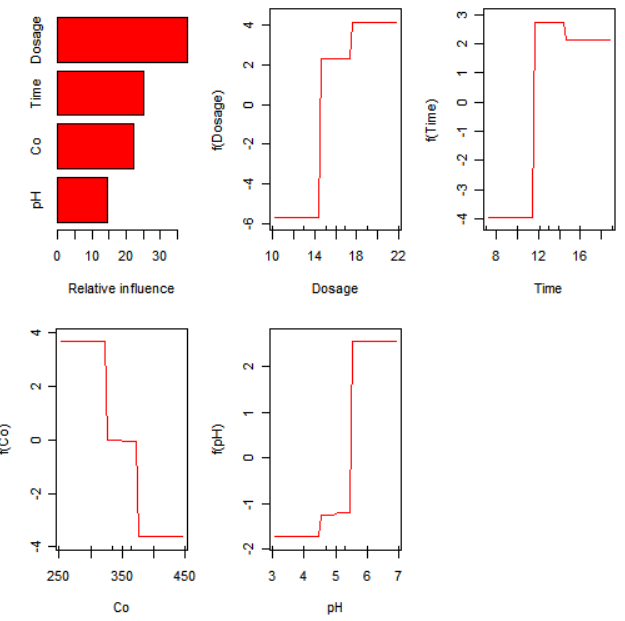
Figure 23. Feature importance for gradient boosting regression tree (GBRT).